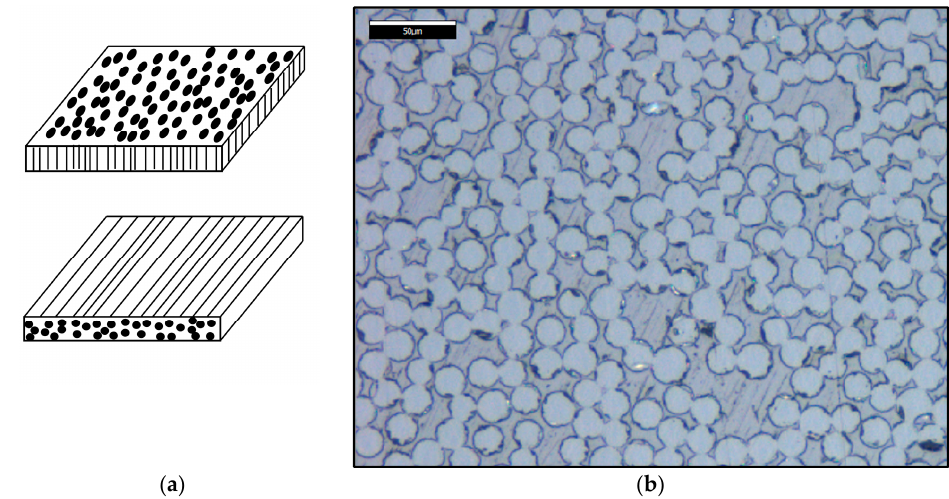
Figure 2. Glass fiber-reinforced epoxy composite plates: ( a ) sample configuration indicating alignment of the fibers in the plate: C3 at the top; C1 at the bottom; ( b ) micrograph of the largest face of the composite plate showing the cross section of the fibers at the surface.